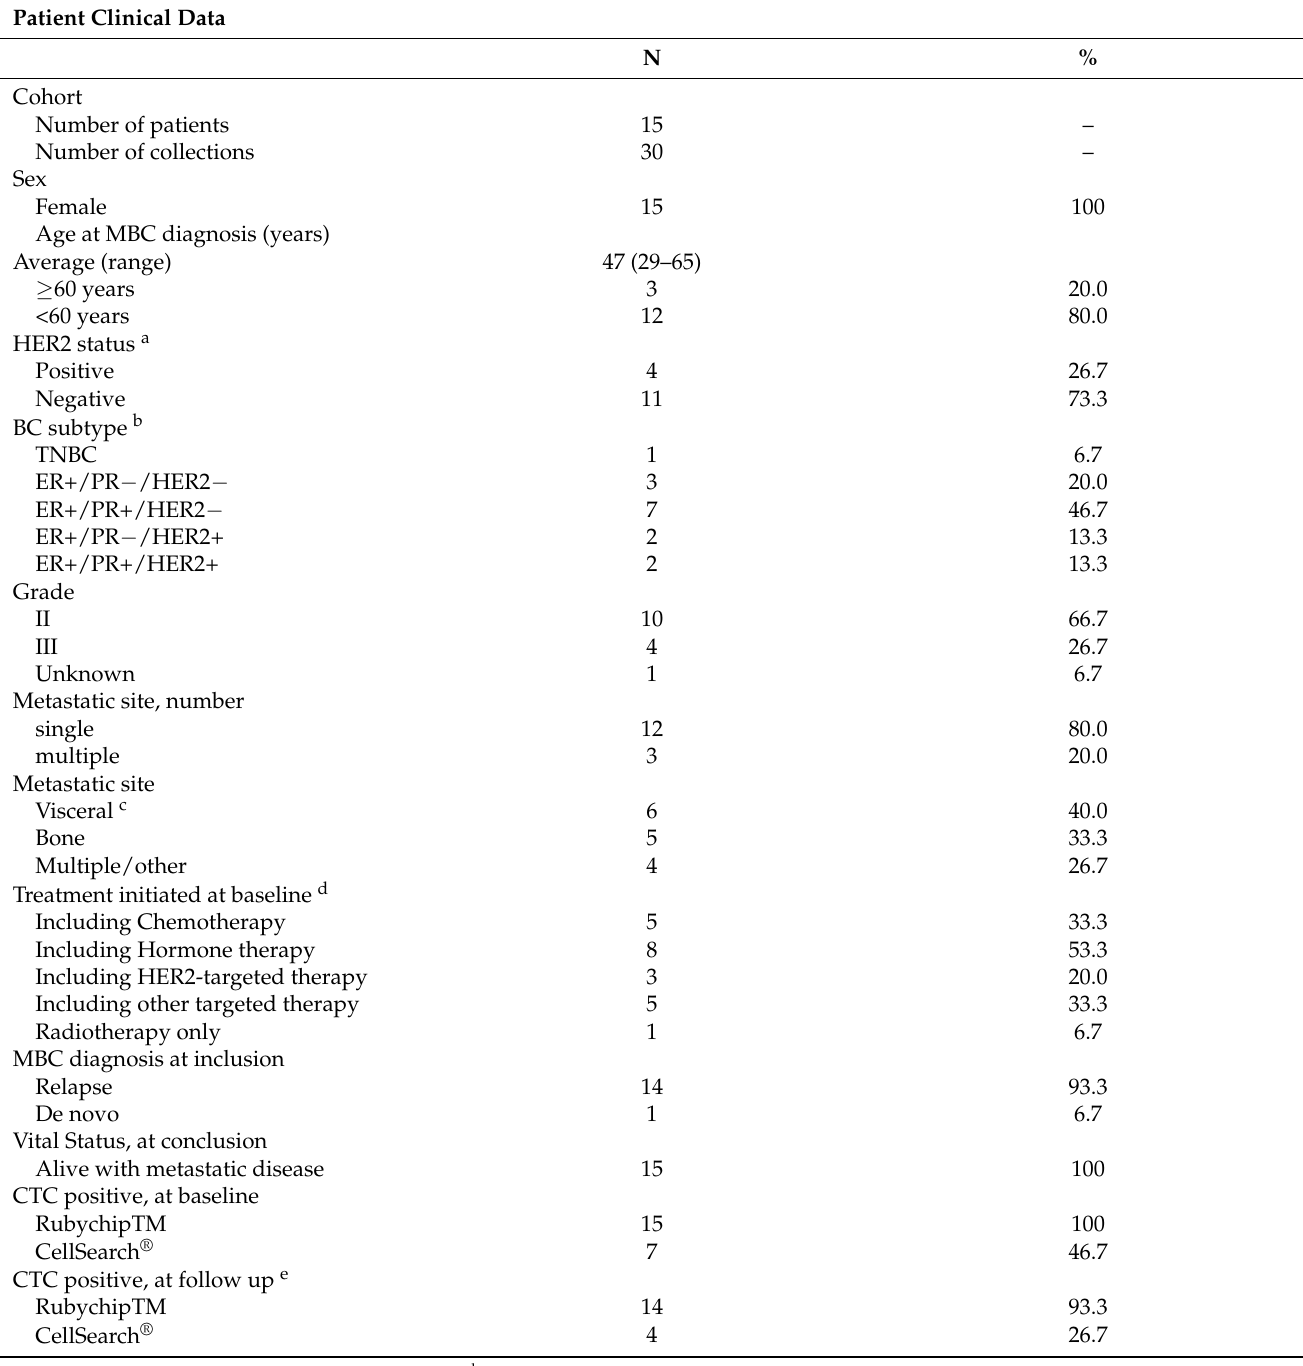
Table 1. Clinicopathological characteristics of patients enrolled in this